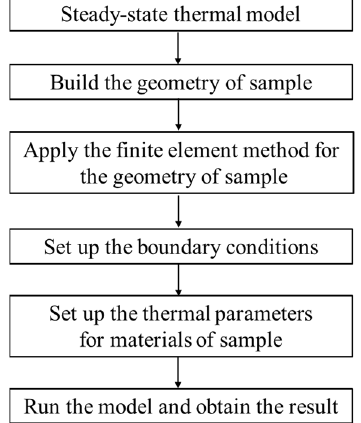
Figure 6. Steps in the steady-state model.